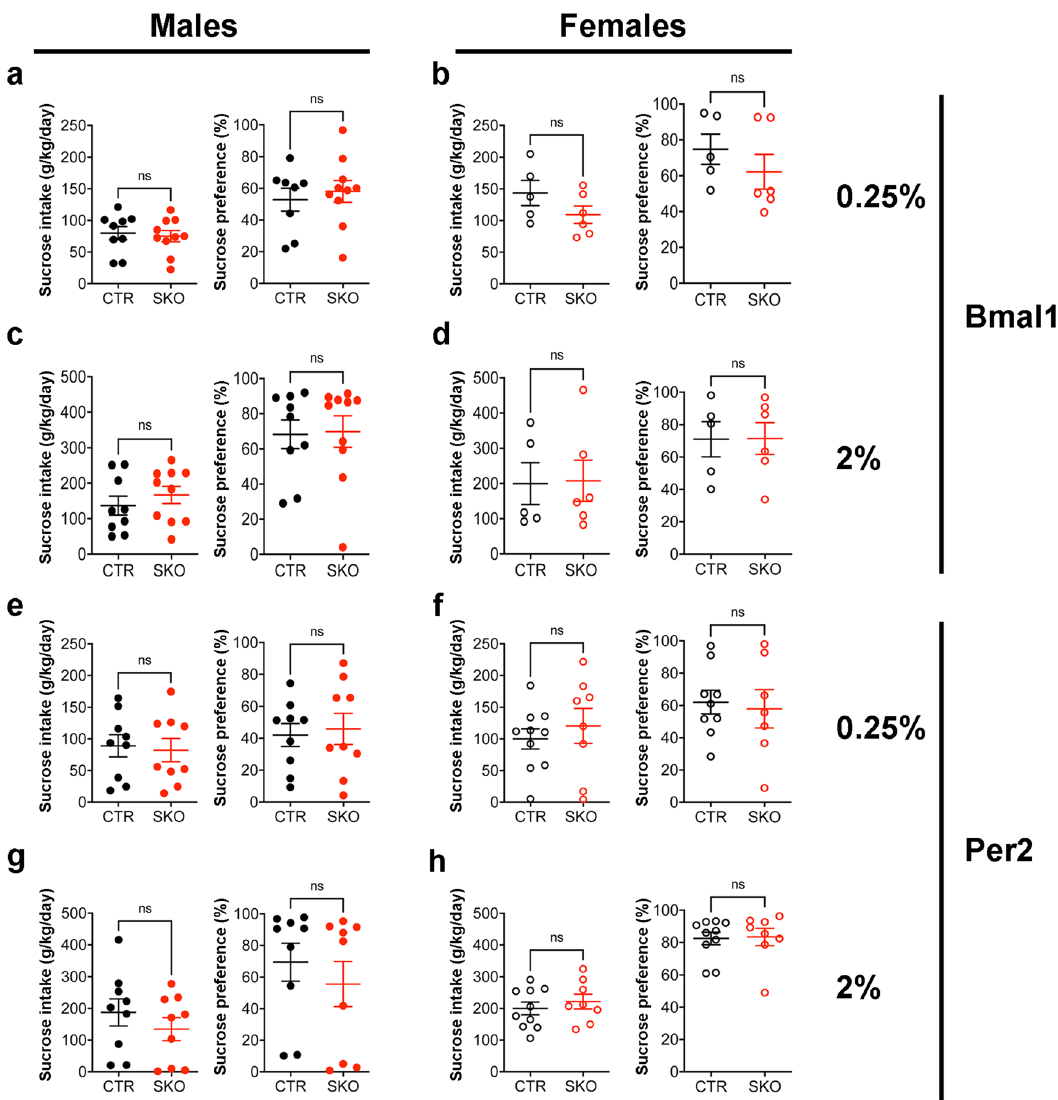
Fig. 4 Drinking behavior of Bmal1 and Per2 knockout mice is independent of changes in the general reward processing. a Average daily intake (left) and preference (right) of 0.25% sucrose solution of control and Bmal1 knockout male mice. Unpaired two-tailed t-test, NS. b Average daily intake (left) and preference (right) of 0.25% sucrose solution of control and Bmal1 knockout female mice. Unpaired two-tailed t-test, NS. c Average daily intake (left) and preference (right) of 2% sucrose solution of control and Bmal1 knockout male mice. Unpaired two-tailed t-test, NS. d Average daily intake (left) and preference (right) of 2% sucrose solution of control and Bmal1 knockout female mice. Unpaired two-tailed t-test, NS. e Average daily intake (left) and preference (right) of 0.25% sucrose solution of control and Per2 knockout male mice. Unpaired two-tailed t-test, NS. f Average daily intake (left) and preference (right) of 0.25% sucrose solution of control and Per2 knockout female mice. Unpaired two-tailed t-test, NS. g Average daily intake (left) and preference (right) of 2% sucrose solution of control and Per2 knockout male mice. Unpaired two-tailed t-test, NS. h , Average daily intake (left) and preference (right) 2% sucrose solution of control and Per2 knockout female mice. Unpaired two-tailed t-test, NS. NS = no signi fi cant differences. a – h , the values express mean±S.E.M. a – d , CTR: Bmal1 control, SKO: Bmal1 Knockout. a , c , CTR n = 9, SKO n = 9. b , d CTR n = 5, SKO n = 6. e – h CTR: Per2 control, SKO: Per2 knockout. e , g CTR n = 9, SKO n = 9. f , h CTR n = 10, SKO n =